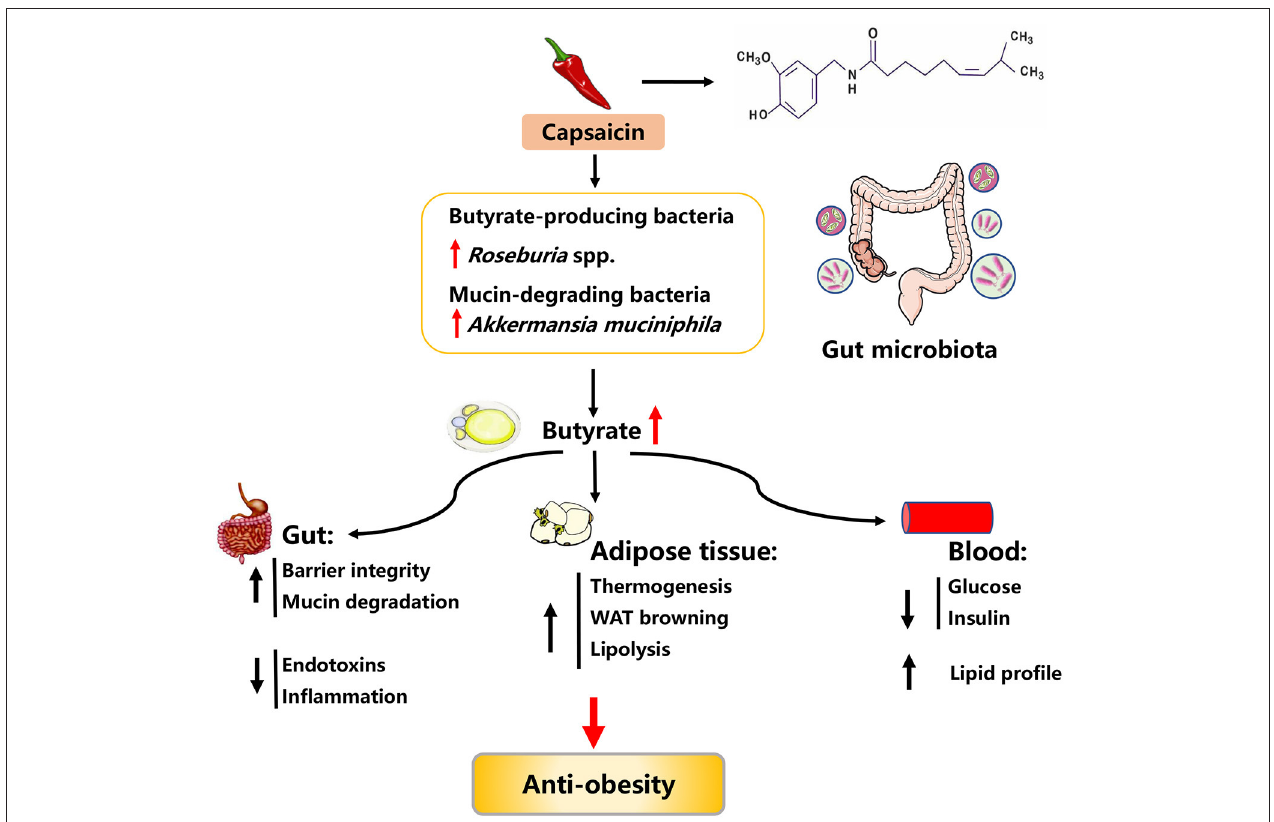
FIGURE 5 | Possible mechanisms explaining the anti-obesity effects of